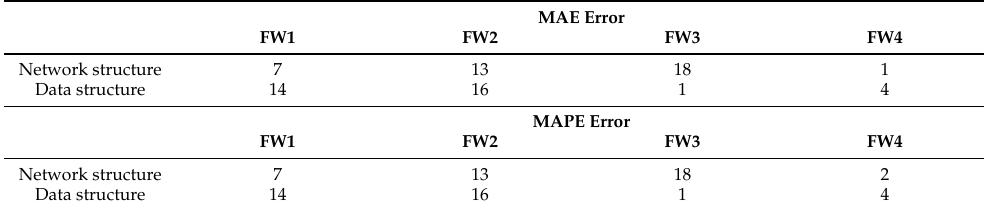
Table 11. Structures for the tested